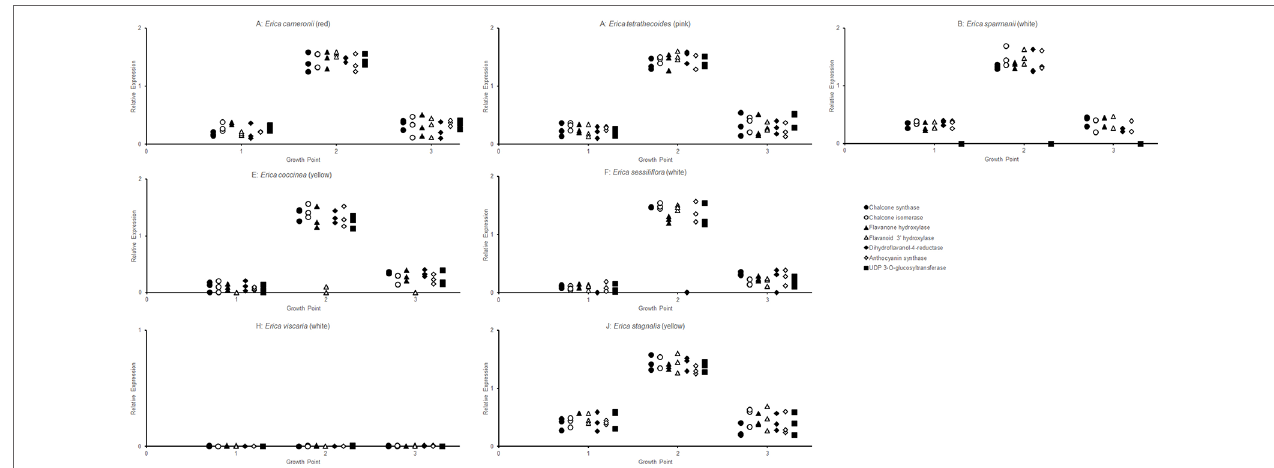
FIGURE 3 | RT-qPCR analysis of the expression of the genes of the anthocyanin biosynthesis at three different growth points of the corolla in each species was evaluated, with three biological replicates of each growth point.